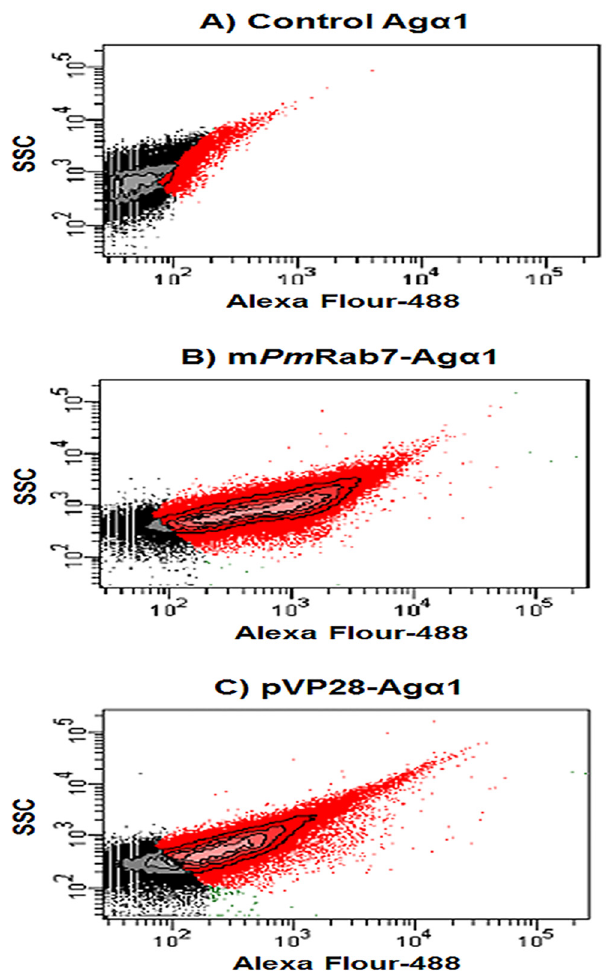
Fig 5. Cell flow cytometry results. (A) Results for negative control Ag α 1p only and showing approximately 20% autofluorescence. (B) Yeast cells expressing m Pm Rab7-Ag α 1p and showing fluorescence for approximately 90% of total events. (C) Yeast cells expressing pVP28-Ag α 1p and showing fluorescence for approximately 70% of total events. The data was selected by relative statistical value from three independent